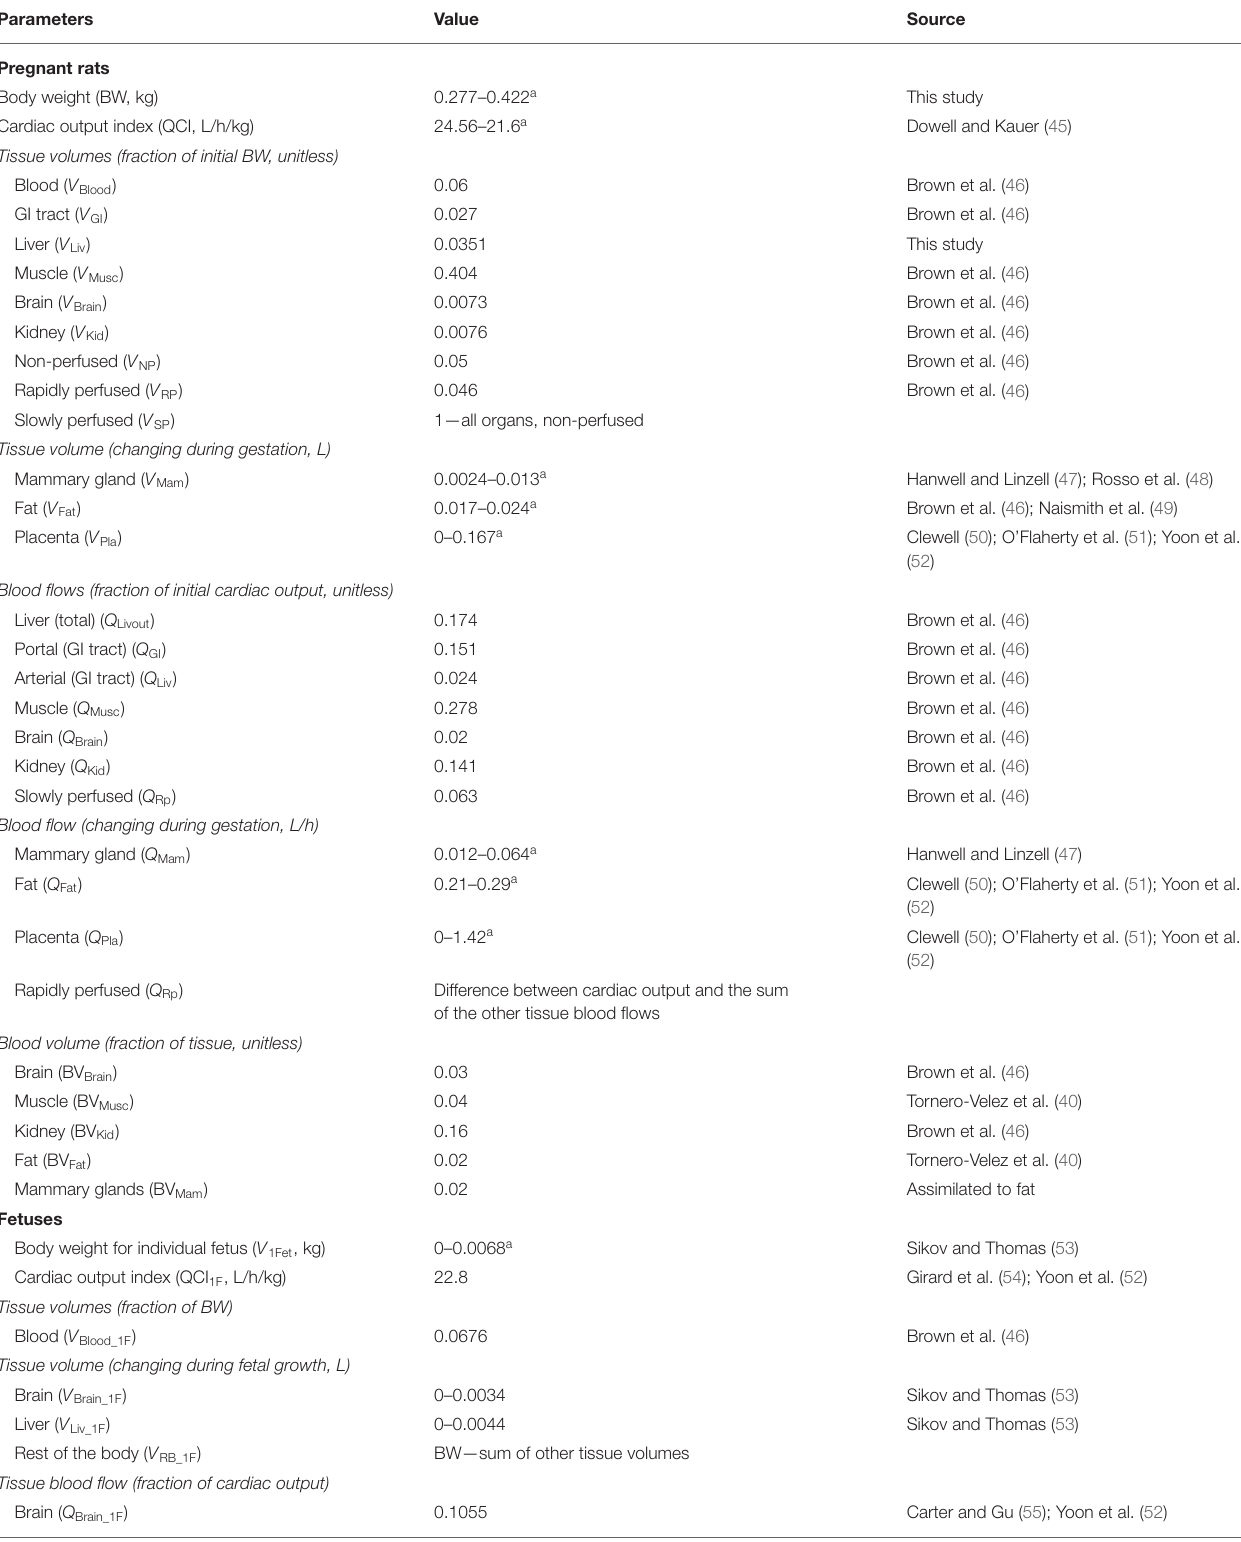
TABLE 1 | Physiological parameters of the maternal and fetal physiologically based pharmacokinetic models for cis - and trans -permethrin. Parameters